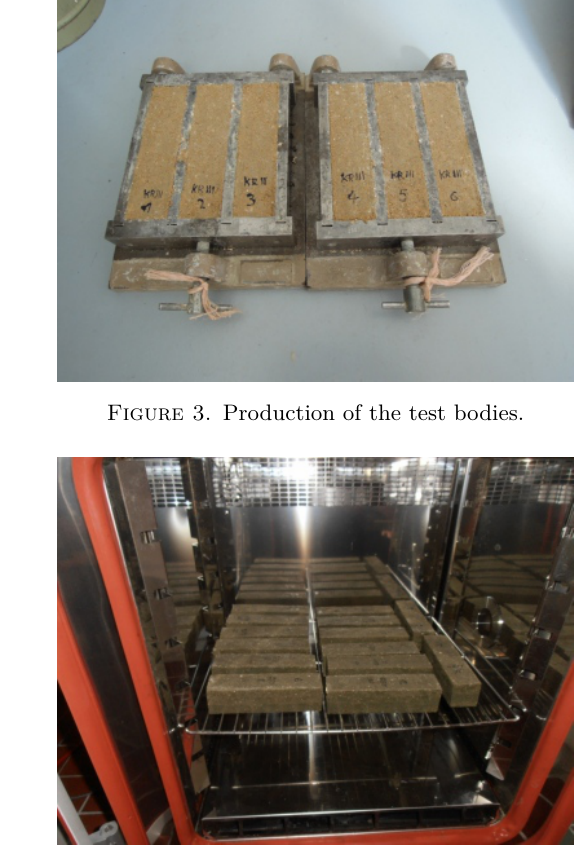
Figure 4. Test bodies in the air-conditioning